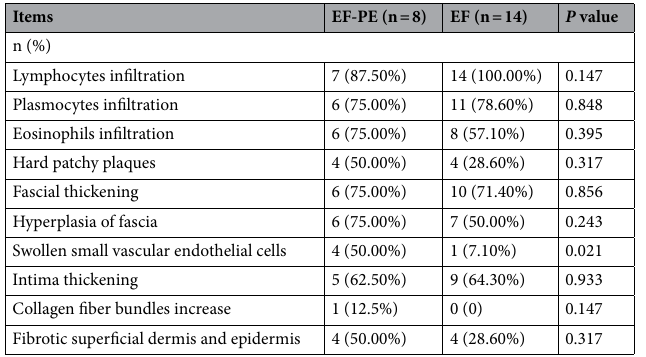
Table 5. Histopathology of the two groups. Comparisons were determined by chi-square test or Fisher’s exact test. P < 0.05 was considered statistically significant.